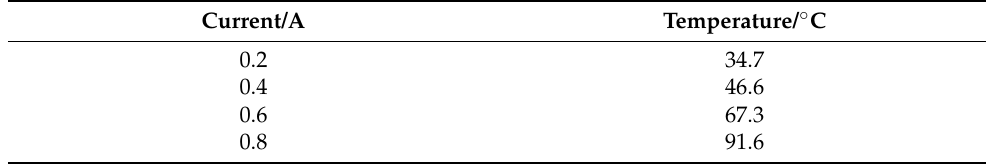
Table 3. Maximum temperature of electromagnet with suspension support under different